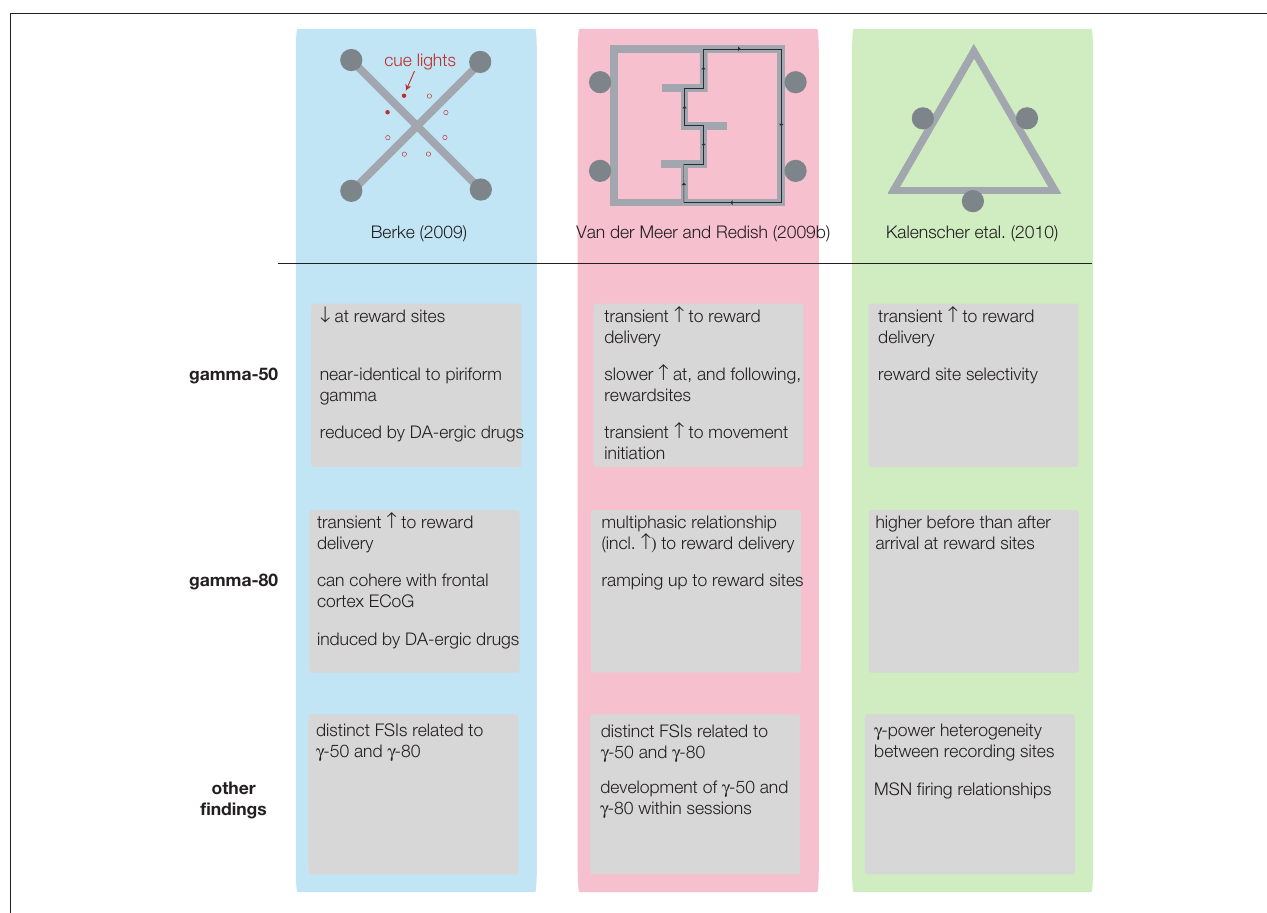
Kalenscher et al. (2010) each reward site provided a different reward. Note that, in the summary of the findings presented here (as in the main text), a distinction is made between “reward delivery”, which is assessed by comparing rewarded and unrewarded trials, and “reward sites” which may include components (such as an anticipatory ramp) independent of actual reward delivery. ECoG, electrocorticogram; DA, dopamine; FSI, fast-spiking interneuron; MSN, medium-sized spiny